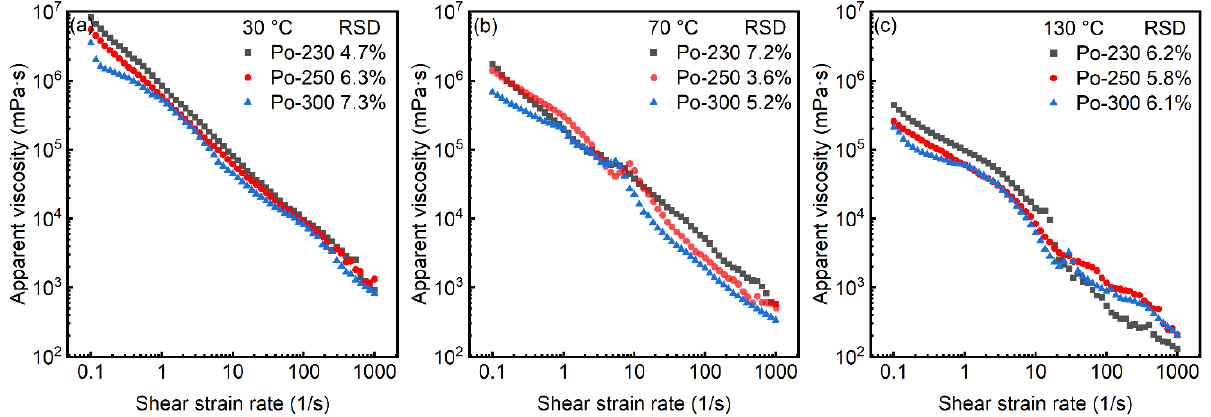
Figure 4. Variations in apparent viscosity with a shear strain rate of polyurea grease with different consistencies at different temperatures: ( a ) 30 °C, ( b ) 70 °C, ( c ) 130 °C. consistencies at different temperatures: ( a ) 30 ◦ C, ( b ) 70 ◦ C, ( c ) 130 ◦